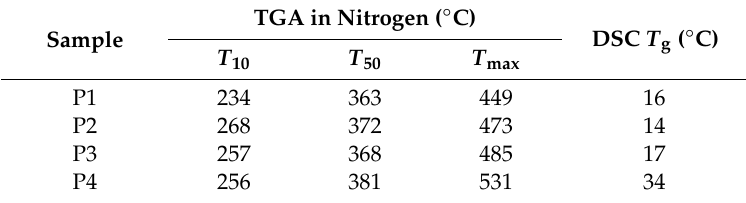
Figure S1 1 H NMR spectra of (a) epoxy soybean oil (ESO) and (b) soybean oil-based polyols (MA-ESO), Figure S2 1 H NMR spectra of (a) soybean oil-based polyols (MA-ESO) and (b) acetoacetylated soybean oil (MA-ESO-TBA). Figure S3 The GPC of acetoacetylated soybean oil, Figure S4 DSC curves indicate the glass transition temperature ( T g ) of the four films. Figure S5 1 H NMR (400 M) spectrum of epoxy soybean oil (ESO), Figure S6 13 C NMR (400 M) spectrum of epoxy soybean oil (ESO),Figure S7 1 H NMR (400 M) spectrum of soybean oil-based polyols (MA-ESO), Figure S8 13 C NMR (400 M) spectrum of soybean oil-based polyols (MA-ESO), Figure S9 1 H NMR (400 M) spectrum of acetoacetylated soybean oil (MA-ESO-TBA), Figure S10 13 C NMR (400 M) spectrum